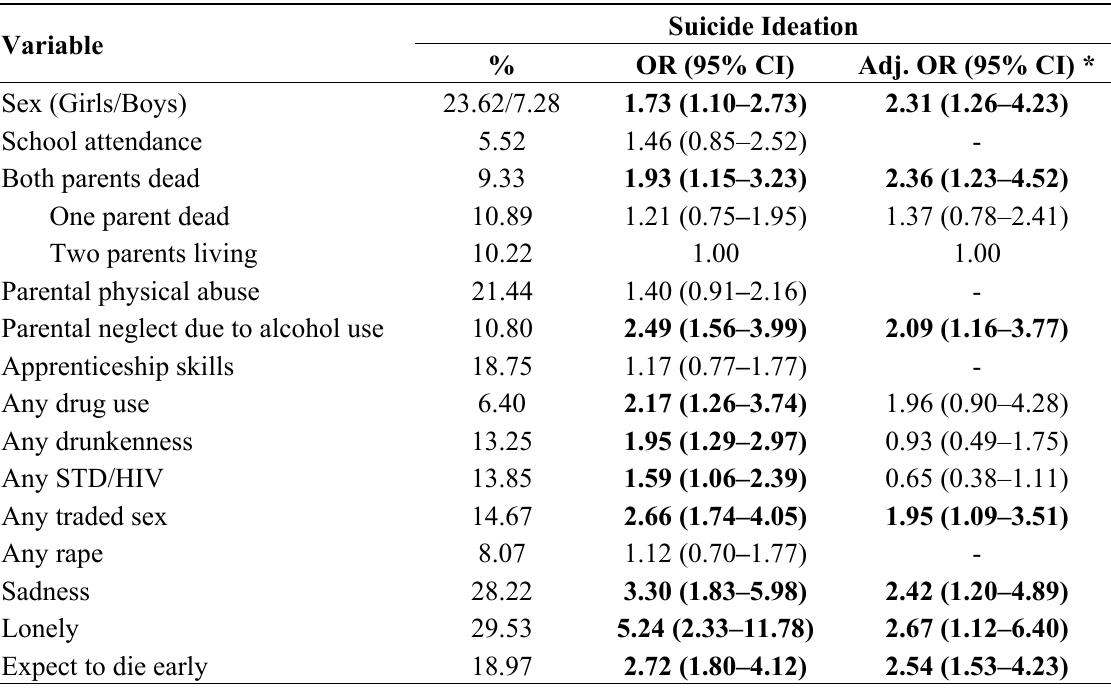
Table 2. Bivariate and multivariate associations between suicidal ideation and demographic characteristics, family context and psychosocial correlates among youth living in the slums of Kampala ( N =